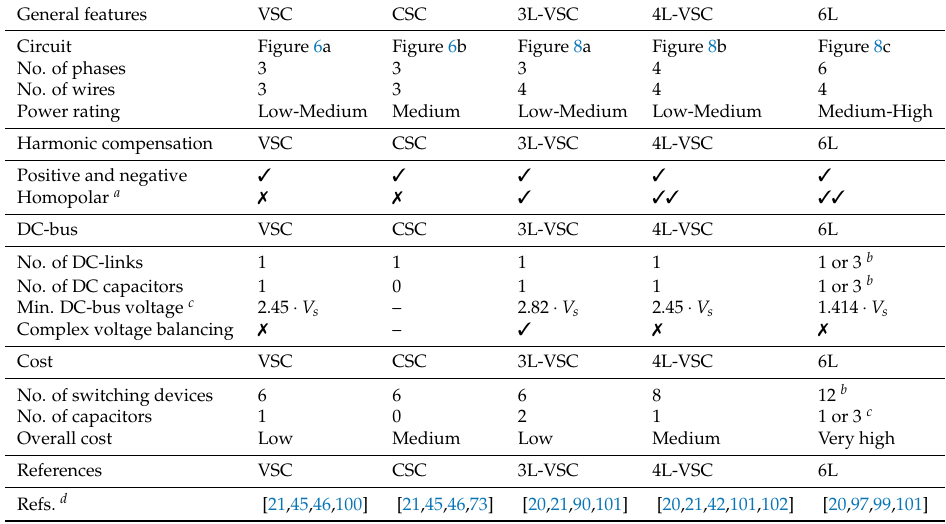
Table 8. Comparison of shunt two-level APF